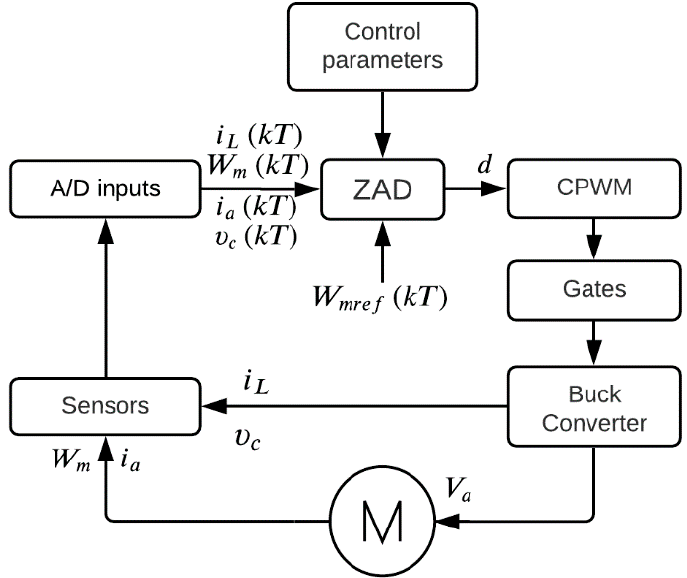
Figure 1. Block diagram of the buck-motor system using ZAD control strategy. The permanent magnet DC motor parameters are as follows: 250 W (nominal power), 42 VDC (input voltage), 6 A (current), and 4000 RPM (speed). The speed of the motor ( W m ) is measured with an encoder of 1000 pulses per turn, υ c is the capacitor voltage that feeds the motor, i L is the inductor current, and i a is the armature current. The controller was implemented in the dSPACE DS1104 [40,41]; therefore, the signals are sampled by the card during the real-time operation, and the output of the control is applied to the buck